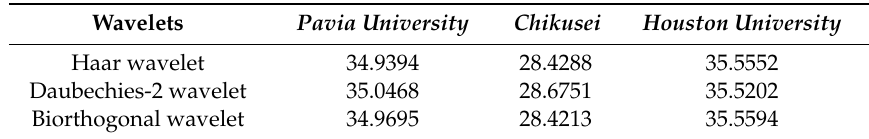
Table 11. PSNR (dB) indices of MW-3D-CNN with di ff erent wavelet functions in WPT. The upscaling factor is